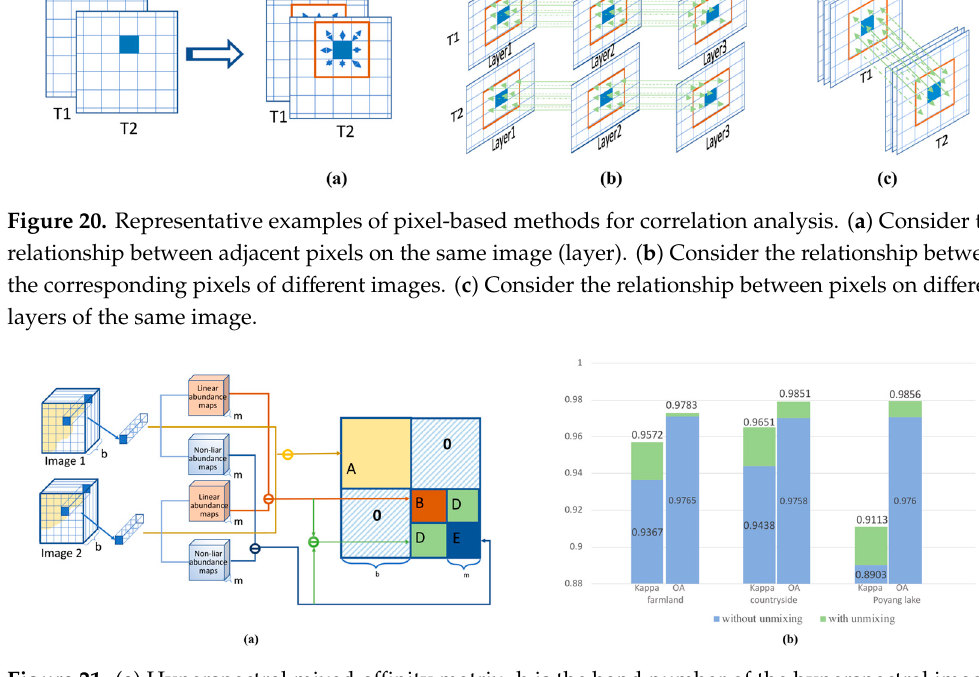
Figure 21. ( a ) Hyperspectral mixed-a ffi nity matrix. b is the band number of the hyperspectral images, and m is the number of endmembers. ( b ) Performance comparison bar chart on whether to use the mixed-a ffi nity matrix.